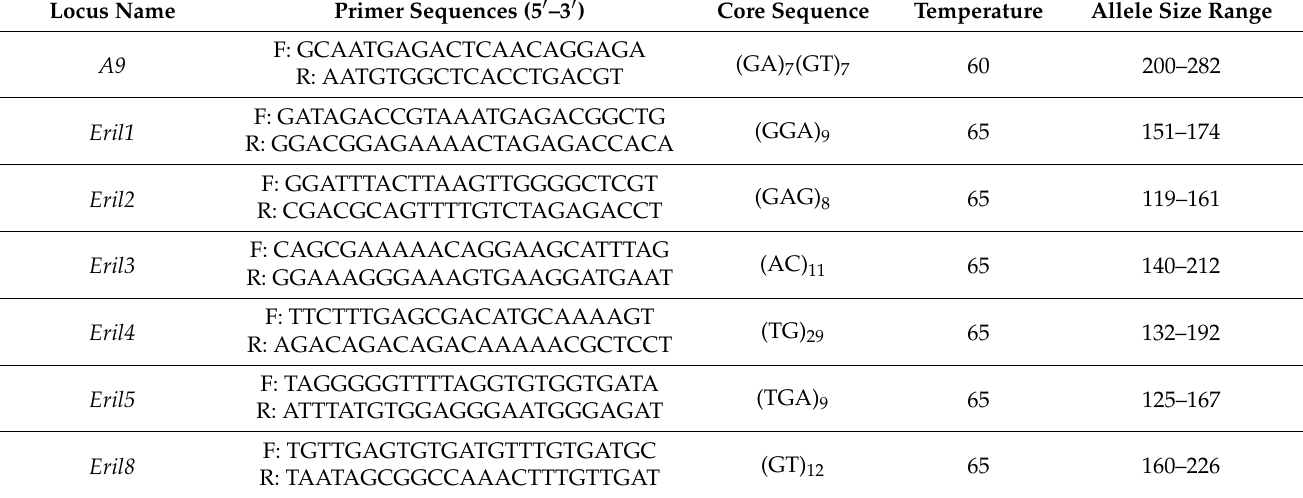
Table 1. Characterization of E. sinensis